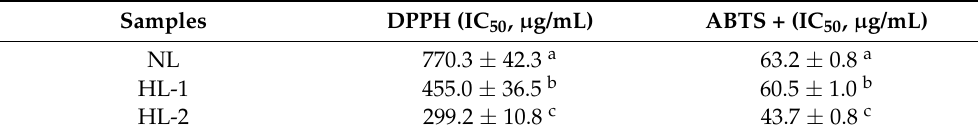
Table 2. Antioxidant activities of the licorice extracts.